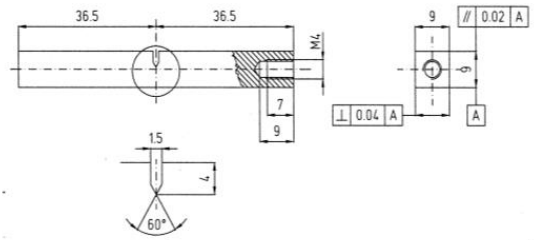
Figure 2. SENB tests specimen.